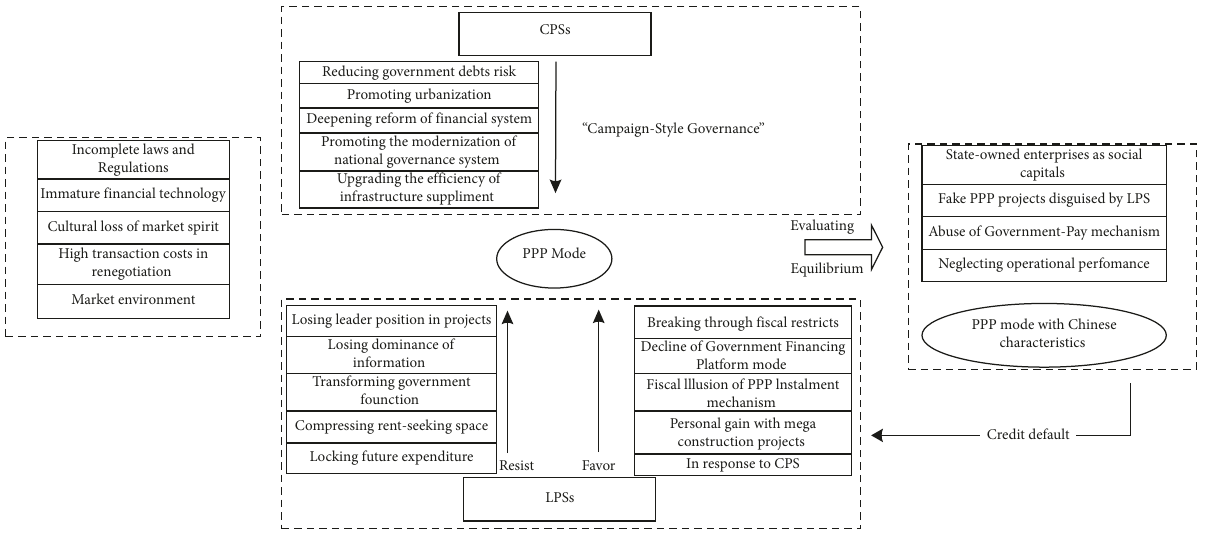
Figure 3: Equilibrium of China PPP promotion.